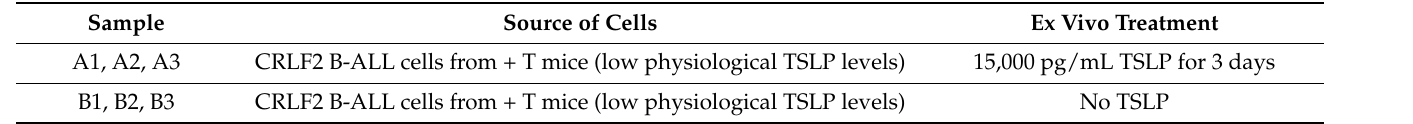
Table 1. Microarray sample